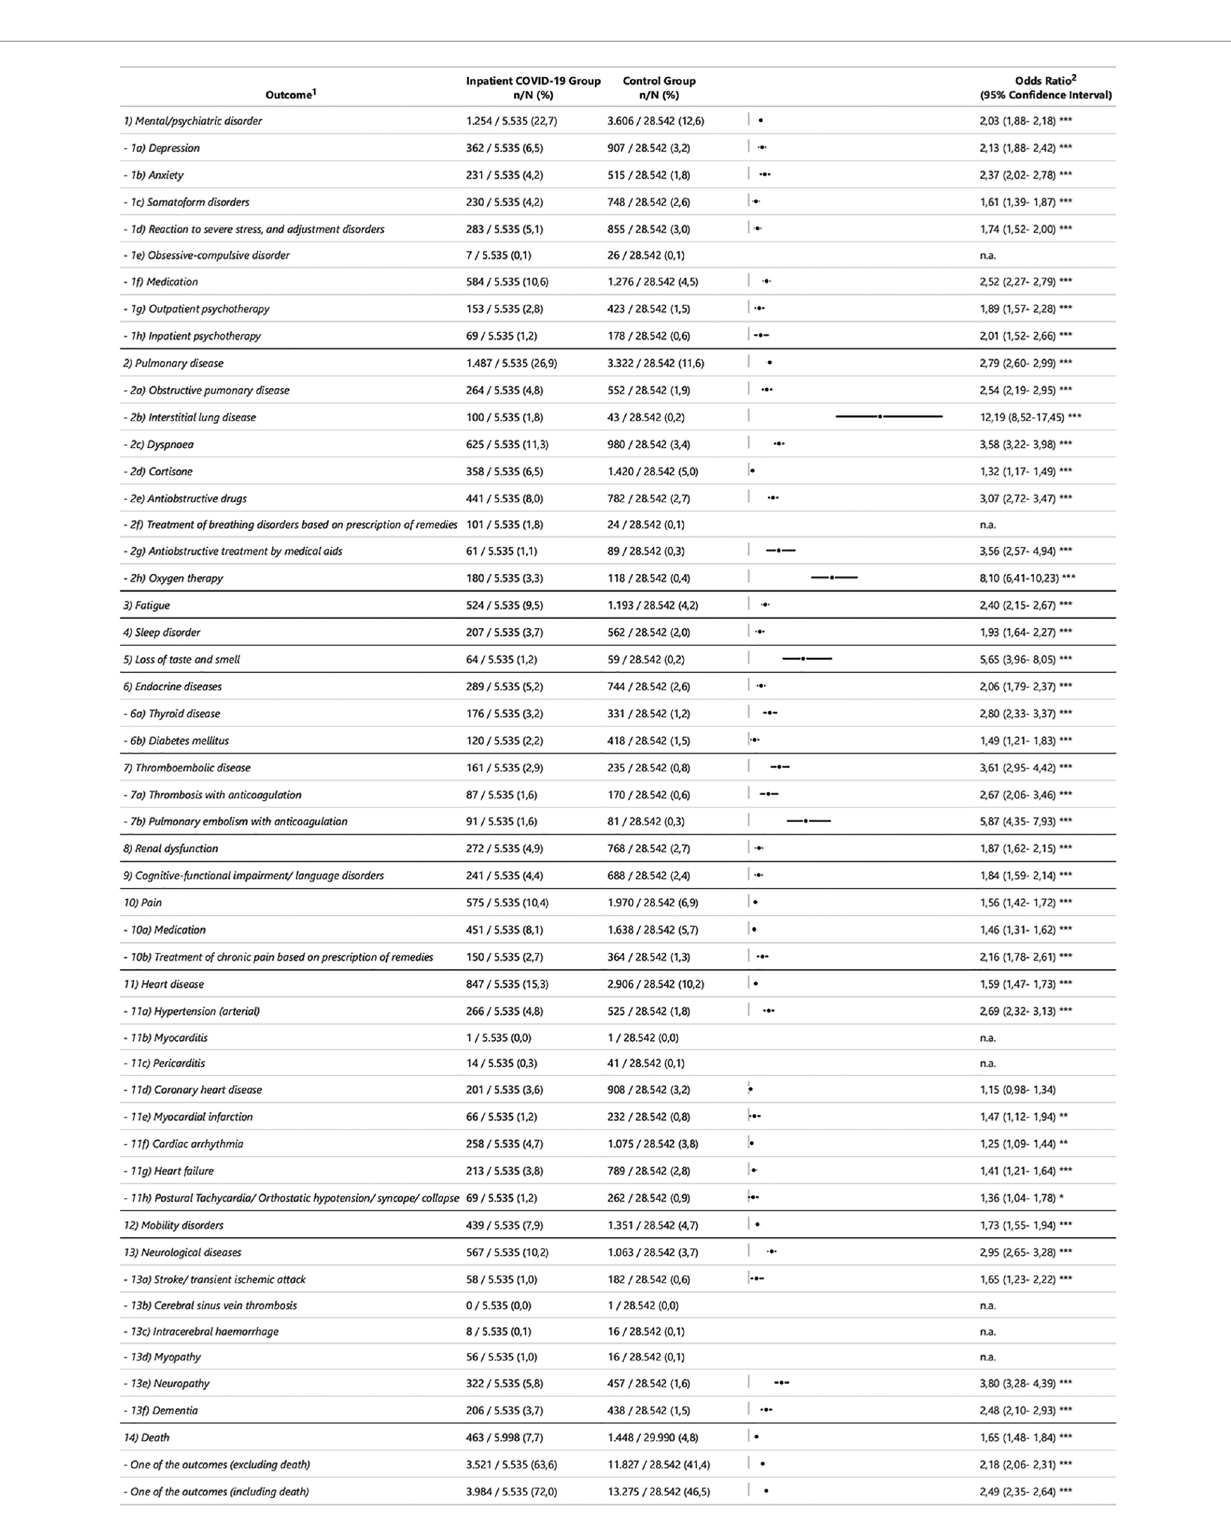
FIGURE 3 Descriptive results and odds ratios of outcome variables in the inpatient sample. 1 Operationalisation of the outcome variables is described in the supplement 1. 2 OR=Odds Ratio; CI=Con fi dence Interval; * p <=0.05; ** p <=0.01; *** p <=0.001; n.a.=not assessed when value <10 (also within the sex